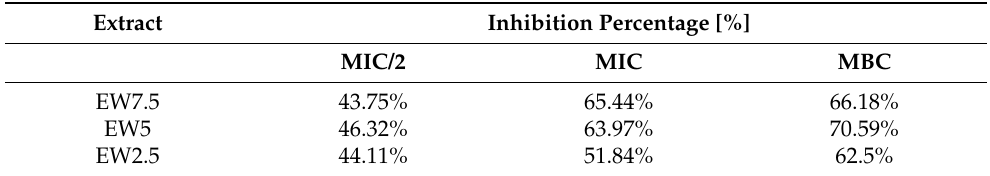
Table 6. Antibiofilm activity of different Allium scrorodoprasum flower extracts on biofilm formation of Staphylococcus lugdunensis .